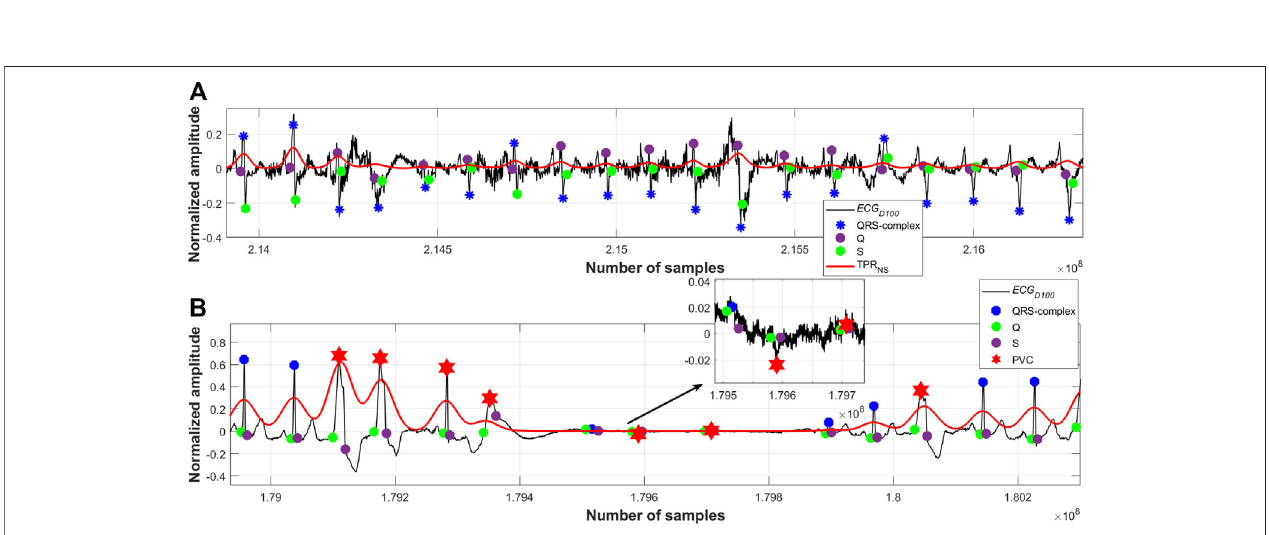
FIGURE 9 | (A) Detected QRS-complexes; record #108m, MITDB, (B) detected QRS-complexes and PVC beats; record #208m, MITDB.